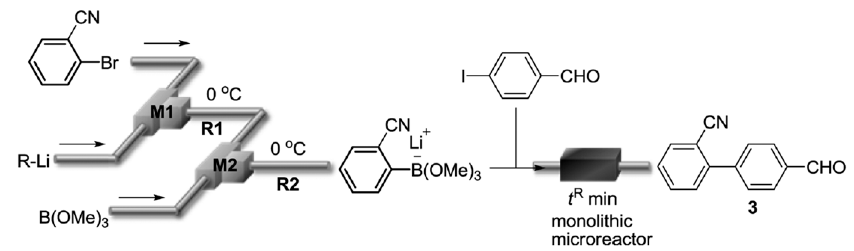
Figure 2. Microreactor system for synthesis of a key intermediate ( 3 ) of valsartan.